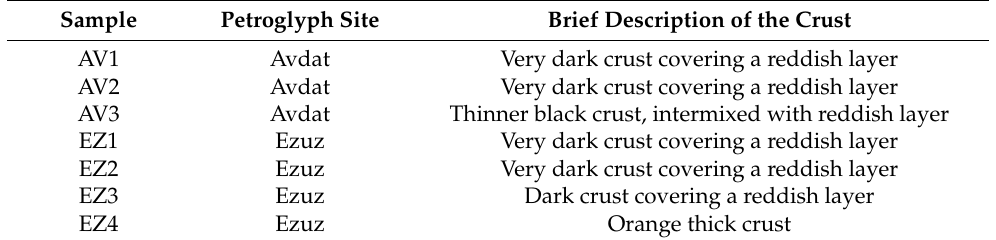
Table 1. List of samples collected at the two petroglyph sites with brief description.